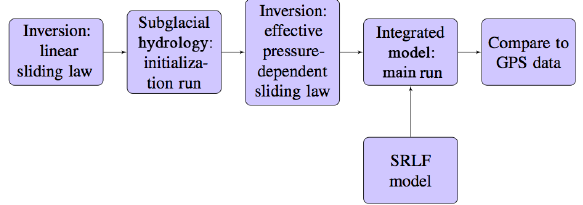
Figure 4. Flow chart showing the work flow for initializing and running the integrated